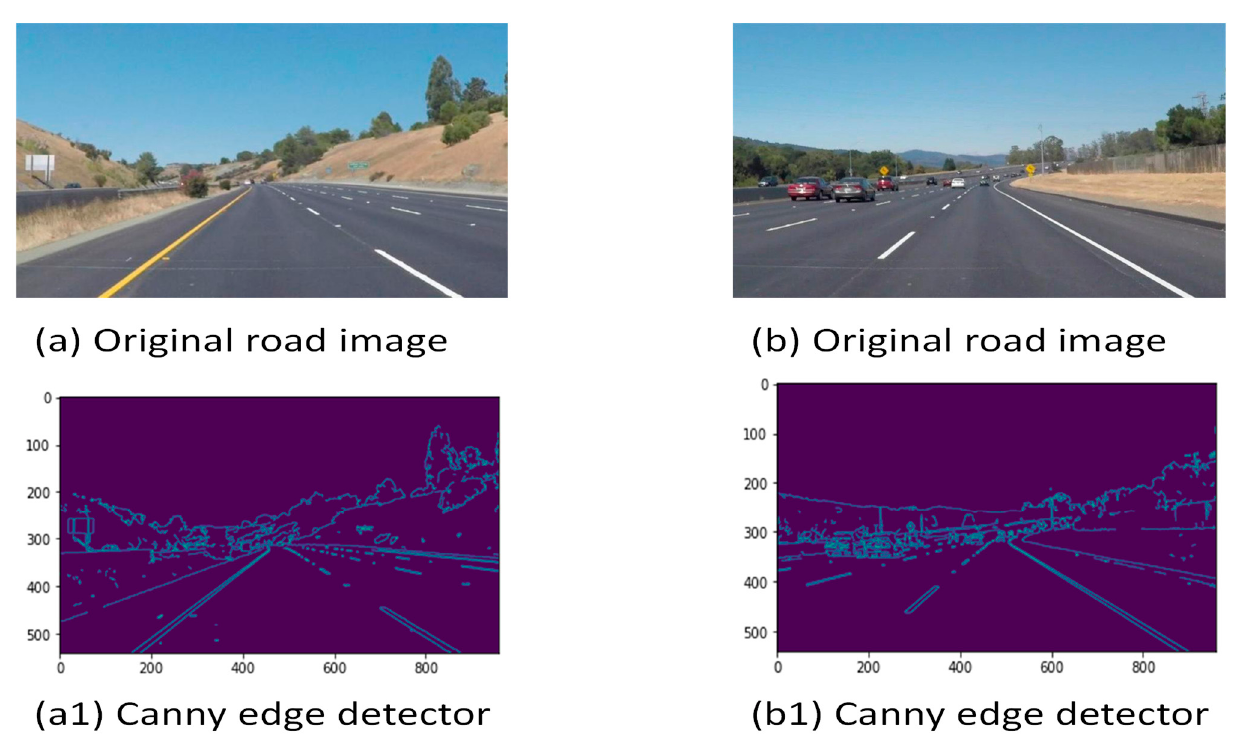
Figure 7. Canny edge feature